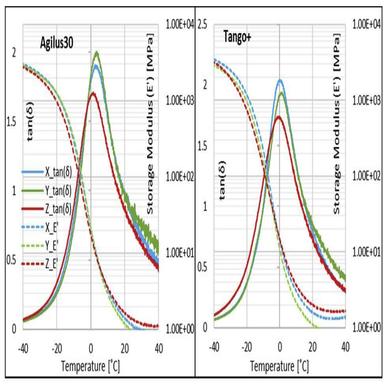
DMA loss tangent and storage modulus (E') results temperatures relevant to glass transition of A30 (left) and T+ (right) samples printed in different orientations.